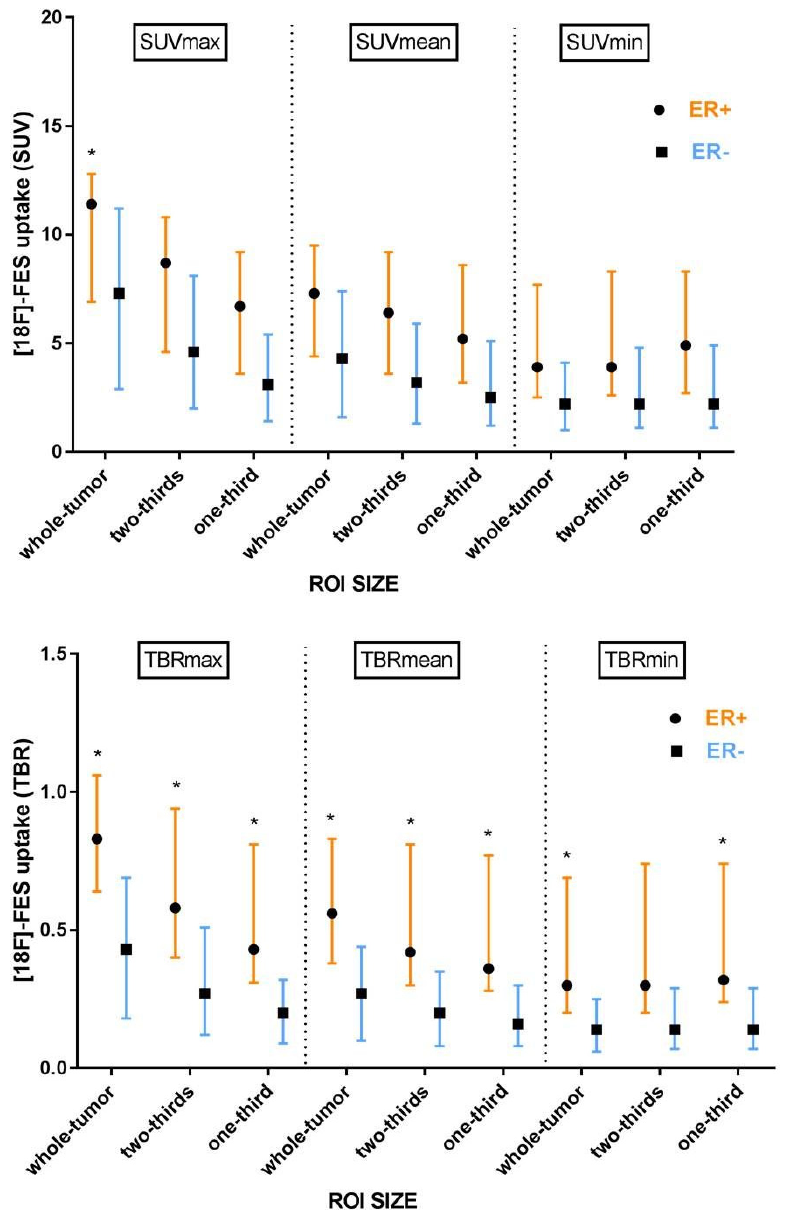
Figure 4. Tumor [ 18 F]-FES uptake in ER+ and ER − liver metastases ( n = 23; median and interquartile range), expressed as standardized uptake value (upper panel) or tumor-to-background ratio (lower panel). * p ≤ 0.05 .